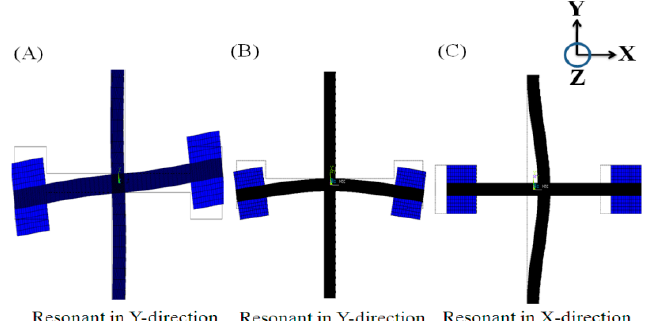
Table 1. FEM simulations of three resonant modes. Figure 3. FEM simulation of three resonant motions. Resonant frequencies were 3428, 4893, and 4908 Hz, respectively.